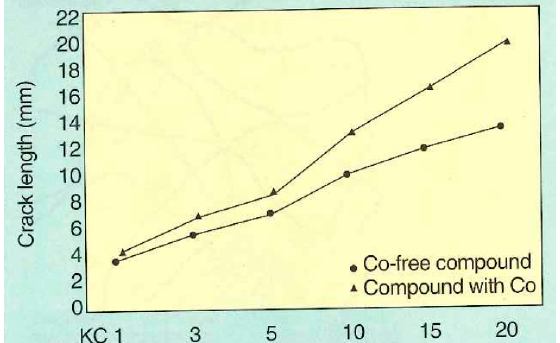
Figure 26. Dynamic crack propagation rate of Cu-Zn-Co and Cu-Zn according to the Demattia test principle: crack length (mm) as a function of the number of flex cycles; LKC = kilocycles). Reprinted with permission from ref. [58].